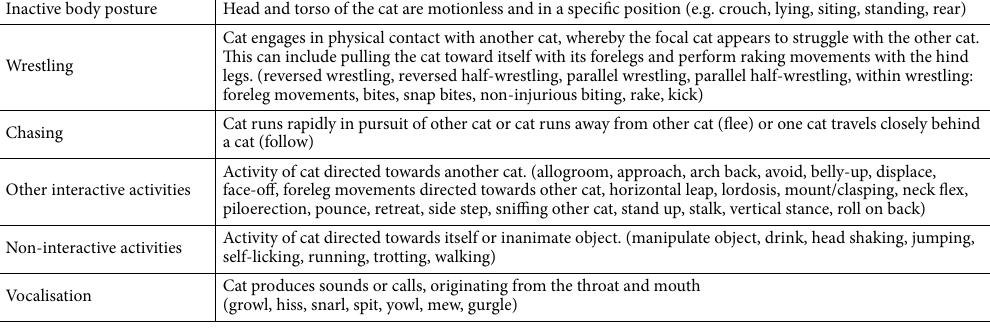
Table 1. Ethogram of inter-cat